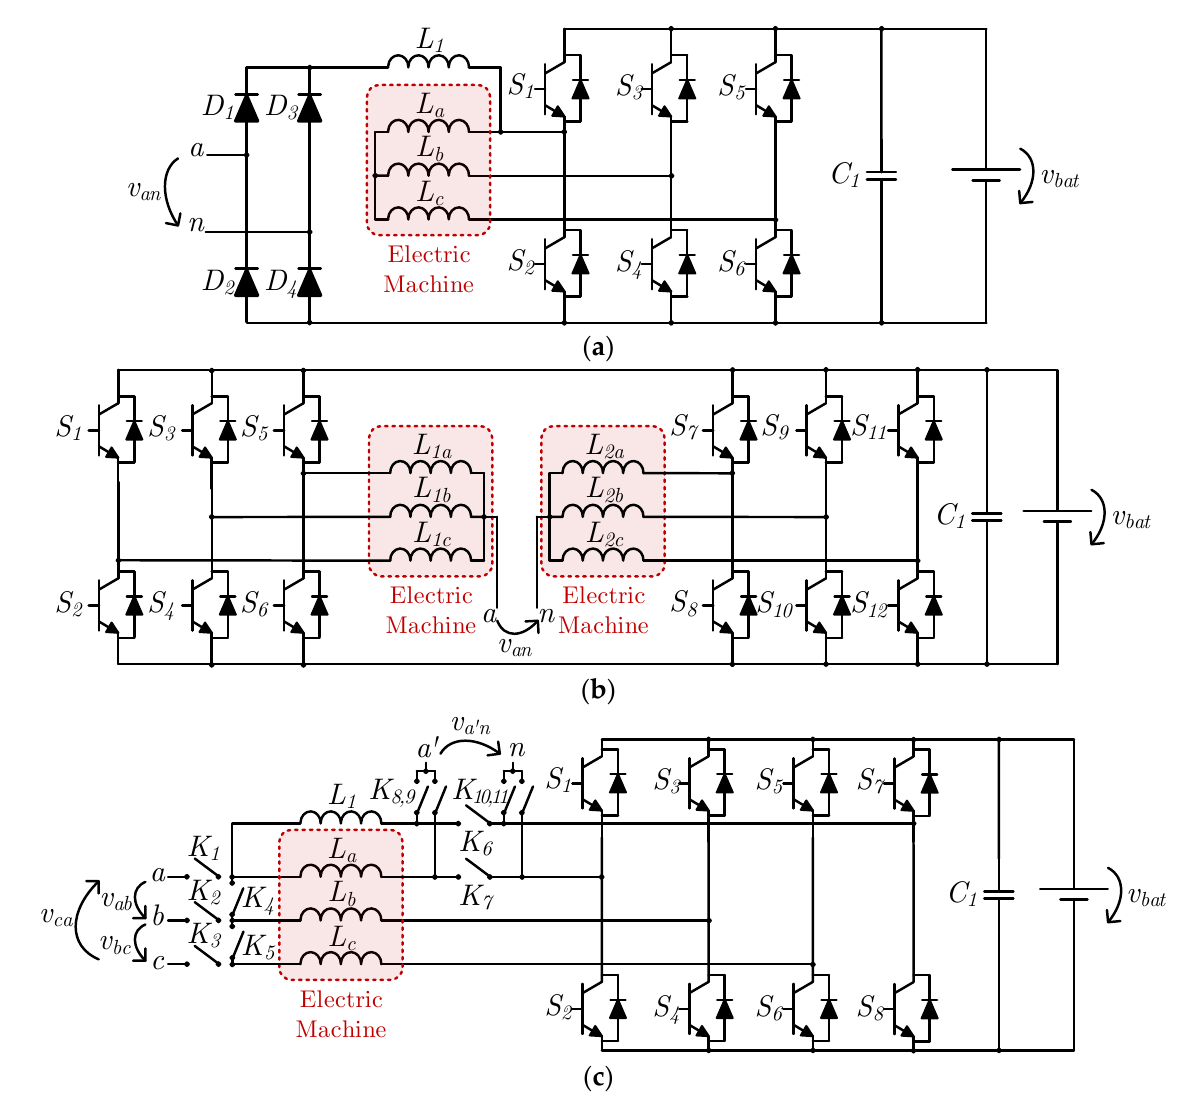
Figure 3. EV IBCs proposed by: ( a ) W. Rippel in 1990 [12]; ( b ) W. Rippel and A. Cocconi in 1992 [13]; ( c ) A. Cocconi in 1994 [14].